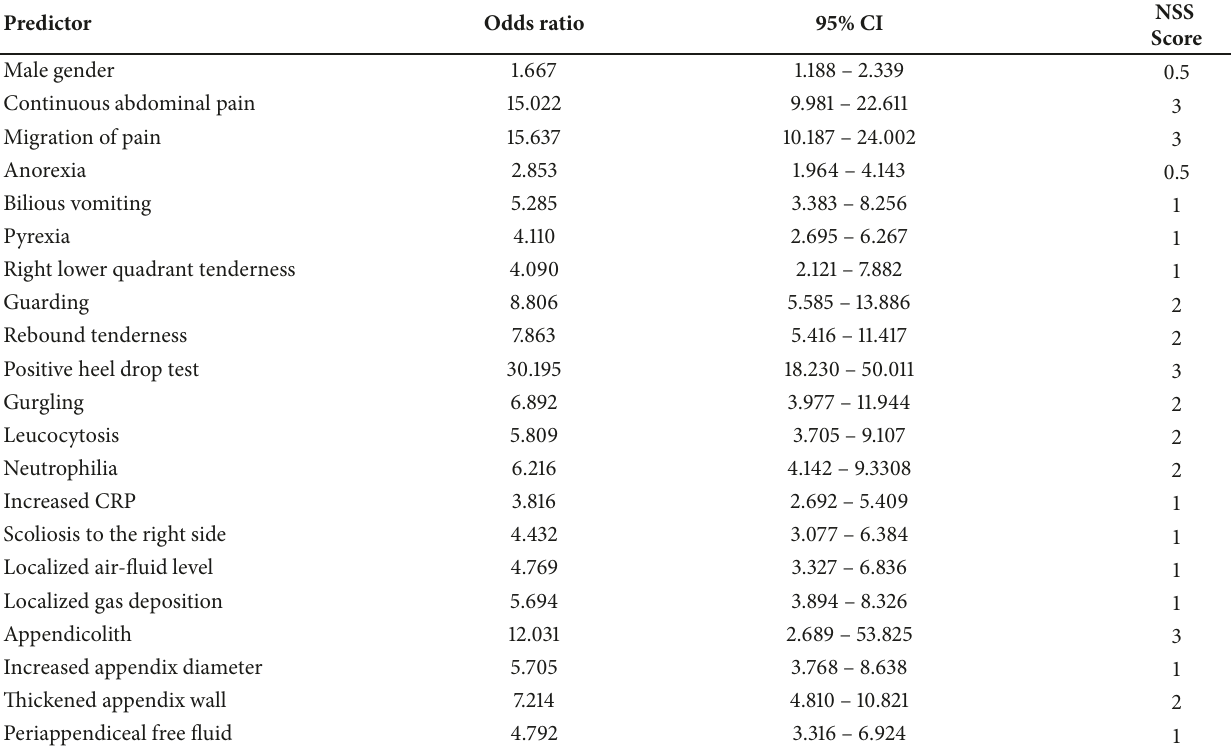
Table 2:Results oflogistic regression anddeterminationof newscoring system (NSS)scores accordingtoodds ratios (CI: confidenceinterval, NSS: new scoring system, and CRP: C-reactive protein).